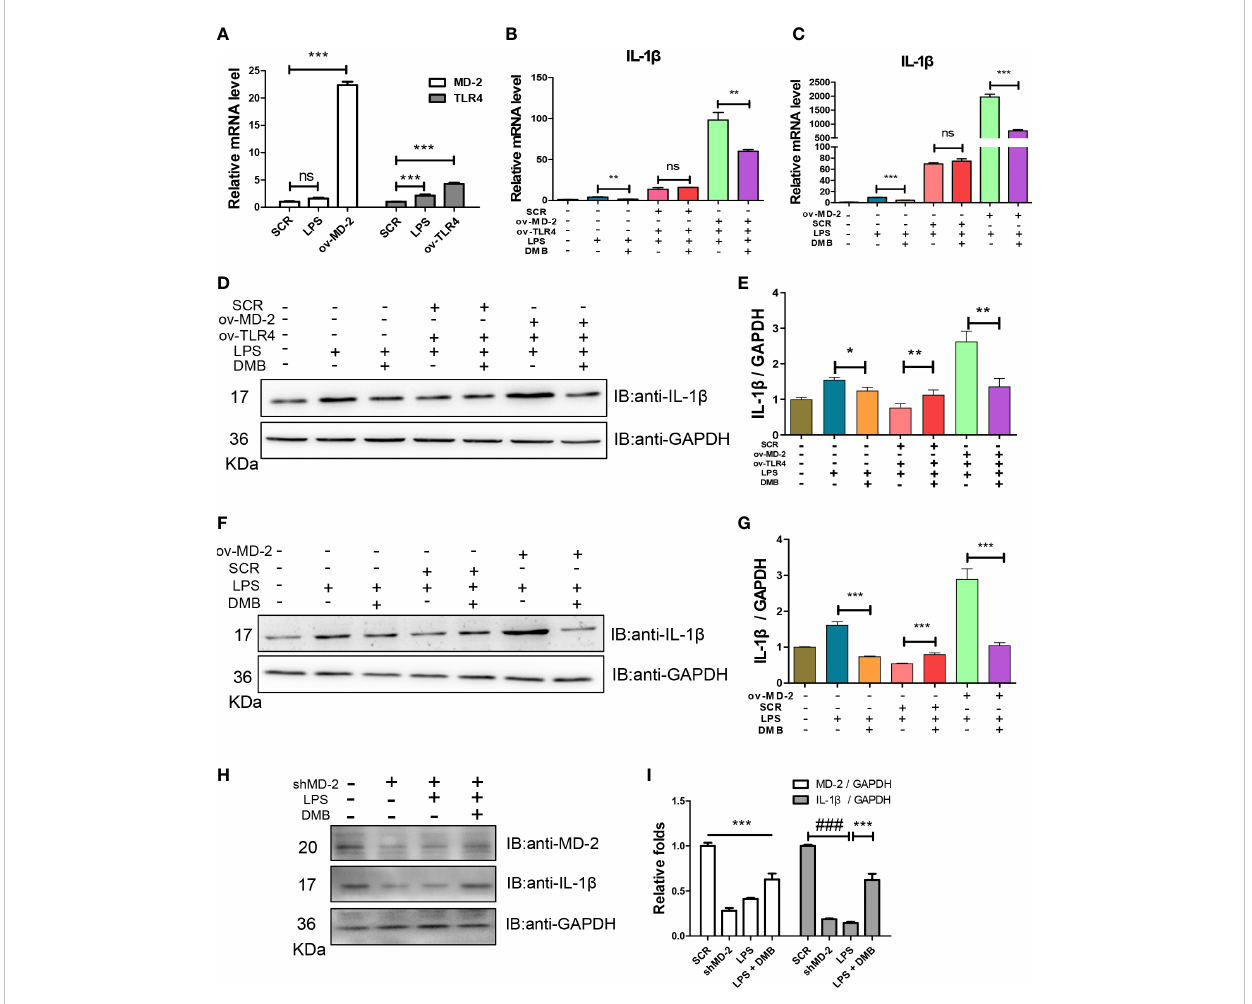
FIGURE 4 DMB blocked TLR4 signaling by targeting the MD-2 protein. (A) The mRNA levels of TLR4 and MD-2 after overexpression of TLR4 and MD-2, respectively. (B) The mRNA levels of IL-1 b after co-overexpression of TLR4 and MD-2. (C) The mRNA levels of IL-1 b after overexpression of MD-2. (D) The protein expressions of IL-1 b after co-overexpression of TLR4 and MD-2. (E) The grayscale analysis of IL-1 b after co-overexpression of TLR4 and MD-2. (F) The protein expressions of IL-1 b after overexpression of MD-2. (G) The grayscale analysis of IL-1 b after overexpression of MD-2. (H) The protein expressions of MD-2 and IL-1 b after interfering with shMD-2. (I) The grayscale analysis of MD-2 and IL-1 b after interfering with shMD-2. Statistical analysis was performed using one-way ANOVA. n = 3. ### p < 0.001 (#: the LPS group versus the SCR group); * p < 0.05, ** p < 0.01, *** p < 0.001, ns: non-signi fi cantly (*: the DMB group versus the LPS